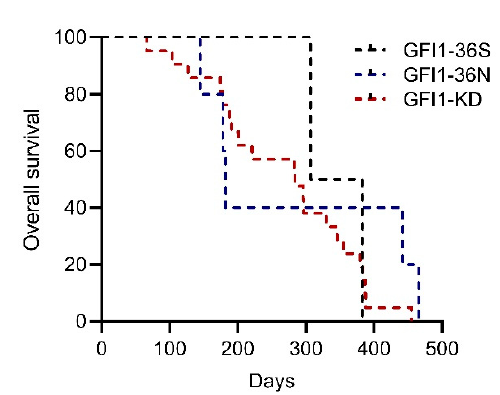
Figure A1. Overview of overall survival GFI1-36S, -36N and –KD, NUP98-HOXD13-tg mice.